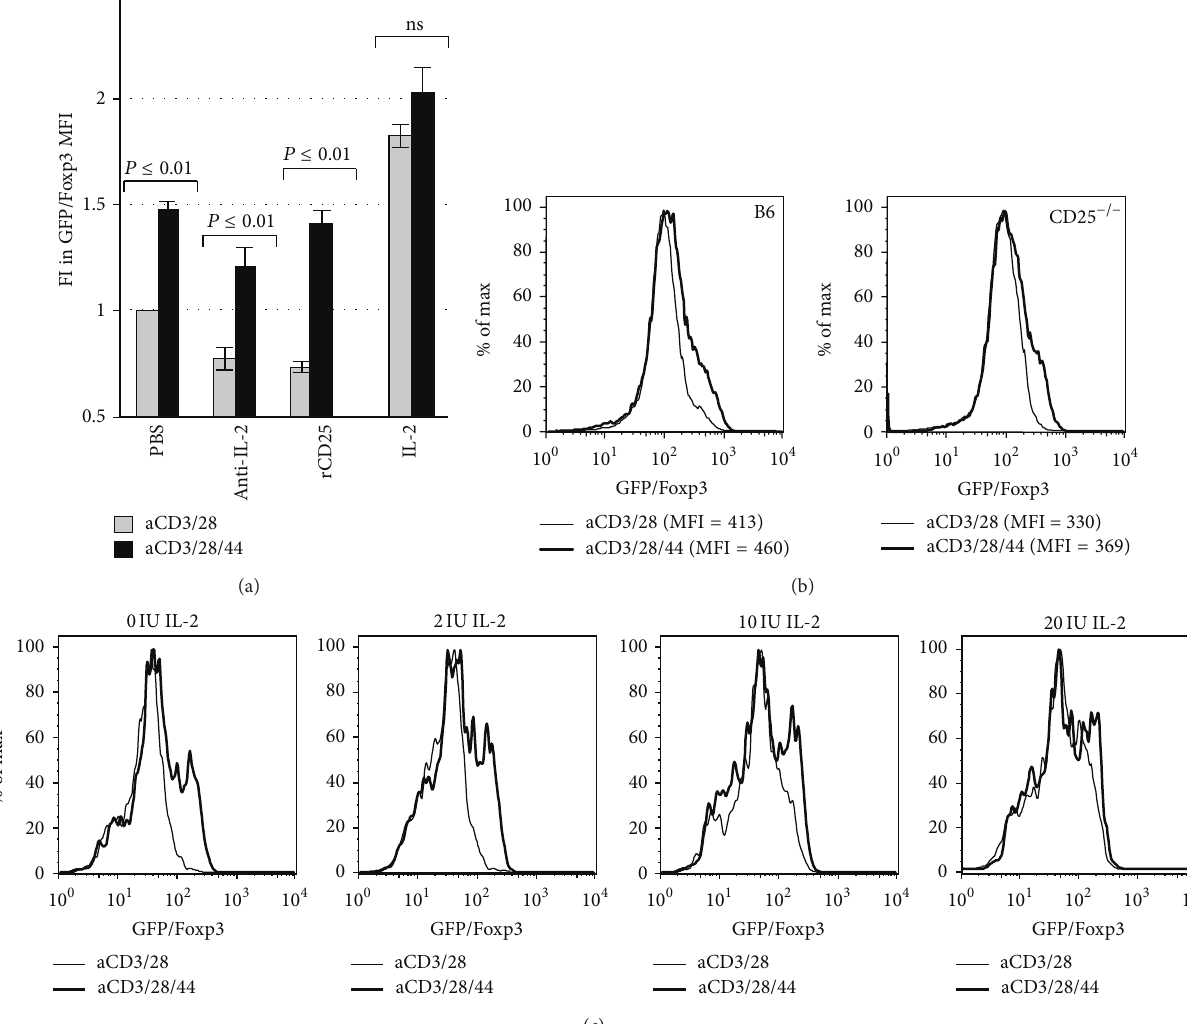
Figure 3: CD44 cross-linking promotes Foxp3 expression in an IL-2-independent manner . (a) Fold Increase (FI) in GFP/FoxP3 MFI for Treg activated with anti-CD3 and anti-CD28 Ab alone or in conjunction with plate-bound anti-CD44 Ab with or without anti-IL-2 Ab (Anti-IL- 2), recombinant CD25 (rCD25), or IL-2 ( 𝑛 = 7 ). (b) Representative histograms demonstrating GFP/Foxp3 expression by Treg isolated from GFP/Foxp3 knock-in mice on a conventional B6 background mice or on a CD25 −/− background (B6 GFP/Foxp3.CD25 −/− mice) following 3 days of culture with anti-CD3 and anti-28 alone or in conjunction with plate-bound anti-CD44. (c) Representative histograms illustrating GFP/FoxP3 expression of Treg following 3 days of culture with anti-CD3 and anti-CD28 alone, or in conjunction with plate-bound CD44 Ab, and with or without varying doses of IL-2. Data are representative of two